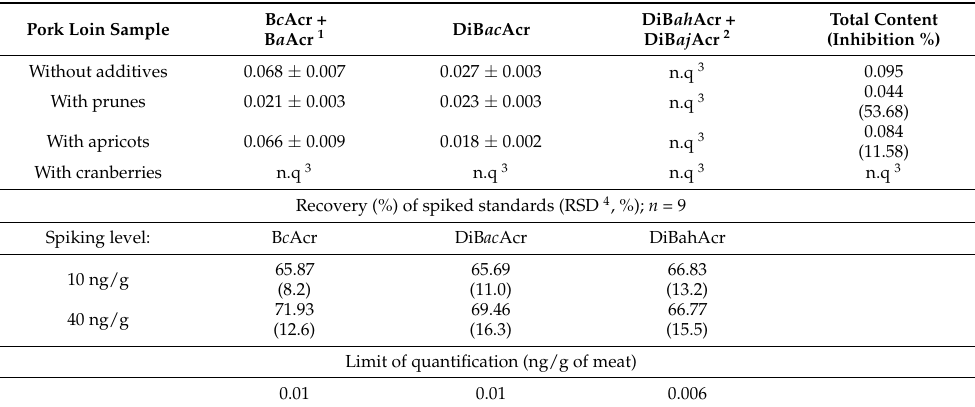
Table 4. Contents (recovery corrected values) of azaarenes in meat cooked with and without additives (ng/g). The results are presented as means ± standard deviations (SD), corresponding to triplicate HPLC analyses of fractions obtained by triplicate extractions ( n = 6).